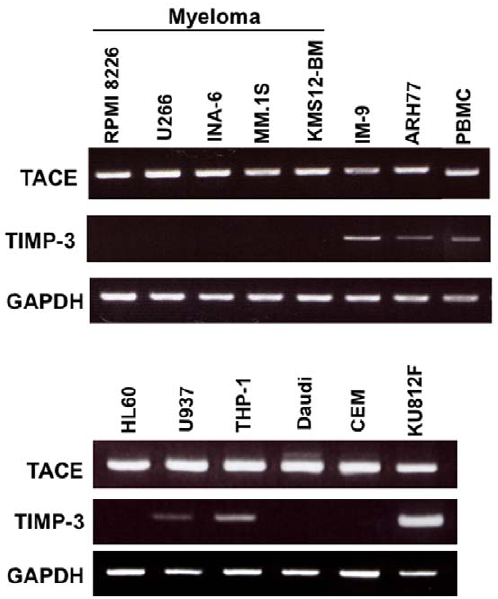
Figure 1. The expression of TACE and TIMP-3 in various types of hematopietic malignant cells. TACE and TIMP-3 mRNA expression was analysed by RT-PCR in MM, B-lymphoid and leukemic cell lines as indicated as well as normal PBMCs. Human GAPDH was used as a housekeeping gene for quantity normalization.